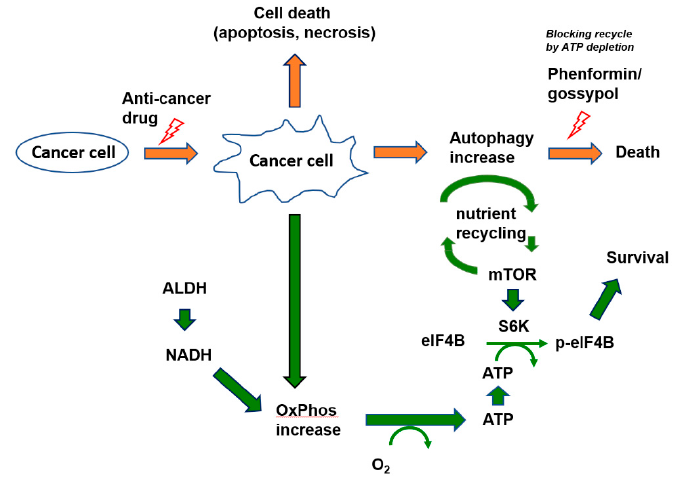
Figure 7. Schematic diagram of targeting cancer resistance by ATP depletion.